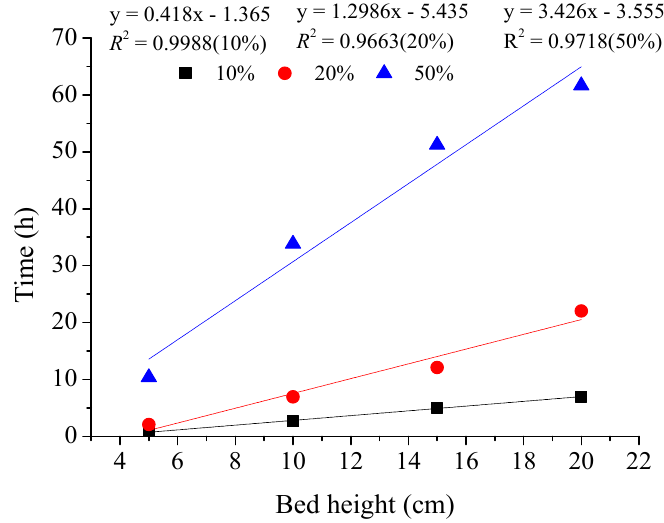
Figure 11. The Adams-Bohart model for 10%, 20% and 50% breakthrough levels at different bed depths and a constant inlet concentration (0.5 mg/L) and residence time (10 min). Table 9. The Adams-Bohart model constants for the adsorption of Cu(II) in lime sand bricks. Iso-Removal Percentage (%)